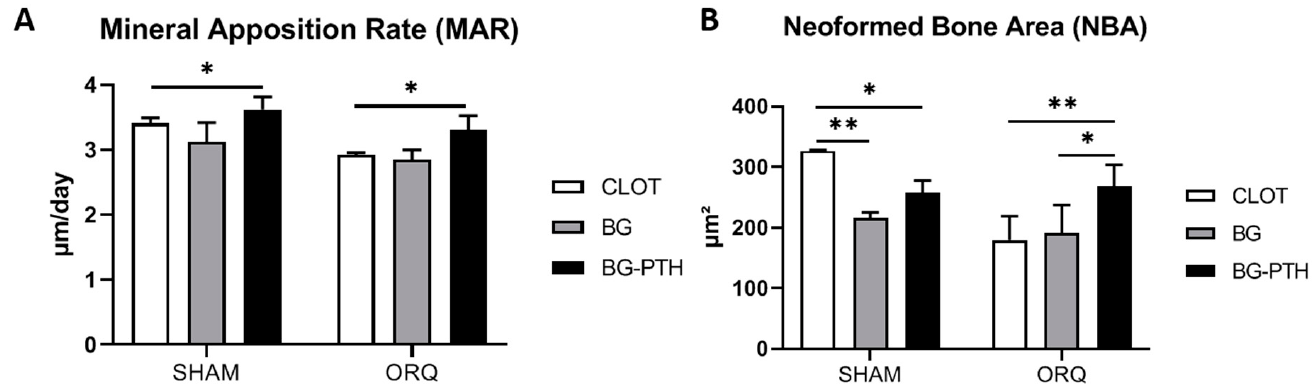
Figure 3. Fluorochrome analysis. ( A ) Mineral apposition rate (MAR). ( B ) Bone area formed (NBA). Asterisks (*,**) denote intragroup statistical difference ( p < 0.05). The intergroup difference can be seen in Table 1.